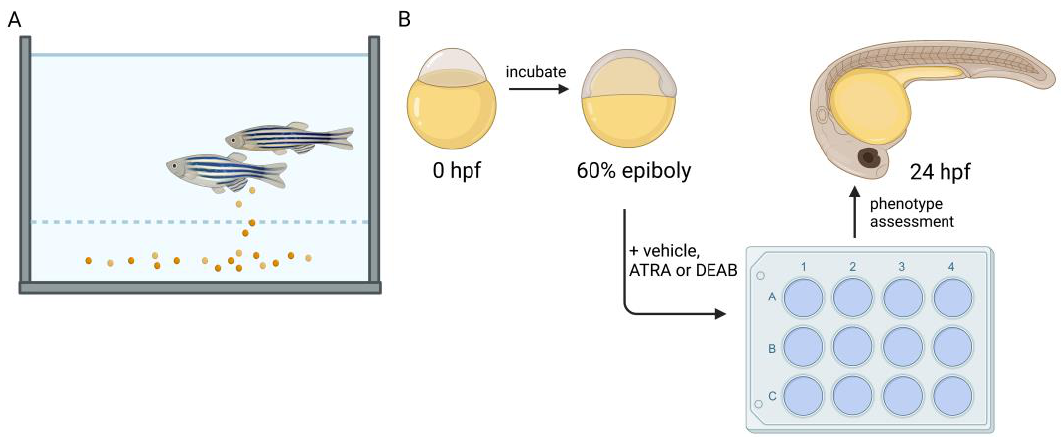
Figure 2. Zebrafish as a model organism. ( A ) Zebrafish adults reach sexual maturity between 2 – 3 months of age and mate via broadcast spawning into the water column. ( B ) Thus, fertilized embryos can be collected non-invasively and grown in the lab. Embryos develop optimally at a temperature of 28.5 ◦ C, as they are tropical fish, and can be grown in various formats. Here, we show the example of arraying the embryos in multi-well plates to conduct exogenous treatments with small molecules to interrogate developmental processes and for toxicology studies. The use of RA pathway agonists or antagonists, like ATRA or DEAB, can be used to interrogate how changes in RA biosynthesis or signaling affect ontogeny. Such treatments can begin at any timepoint of interest to the researcher, such as the 60% epiboly depicted here, and then embryos reared to the stage(s) of interest, such as 24 hpf, to examine the effects by any number of phenotype assessments, such as live assessment, WISH, or qRT-PCR. Figure created with